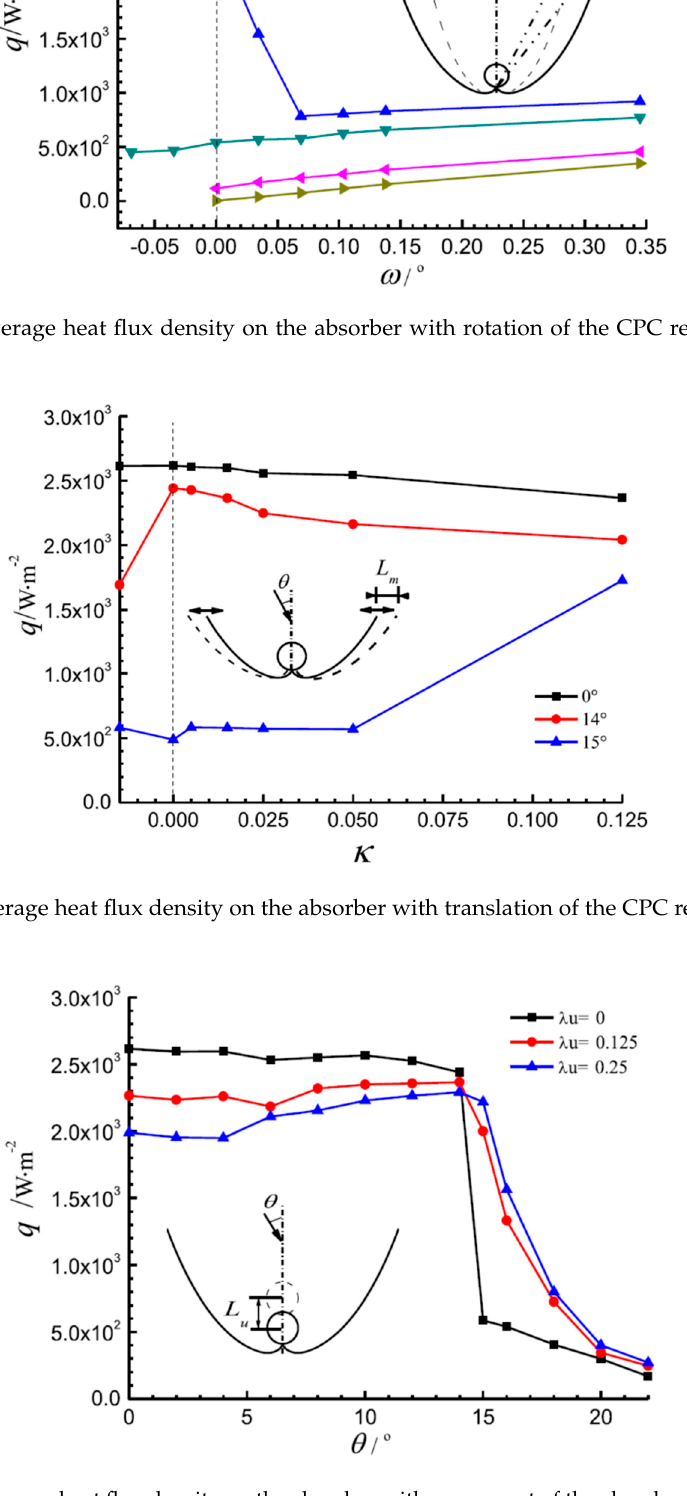
Figure 10. The average heat flux density on the absorber with movement of the absorber ( Ct = 0.5)